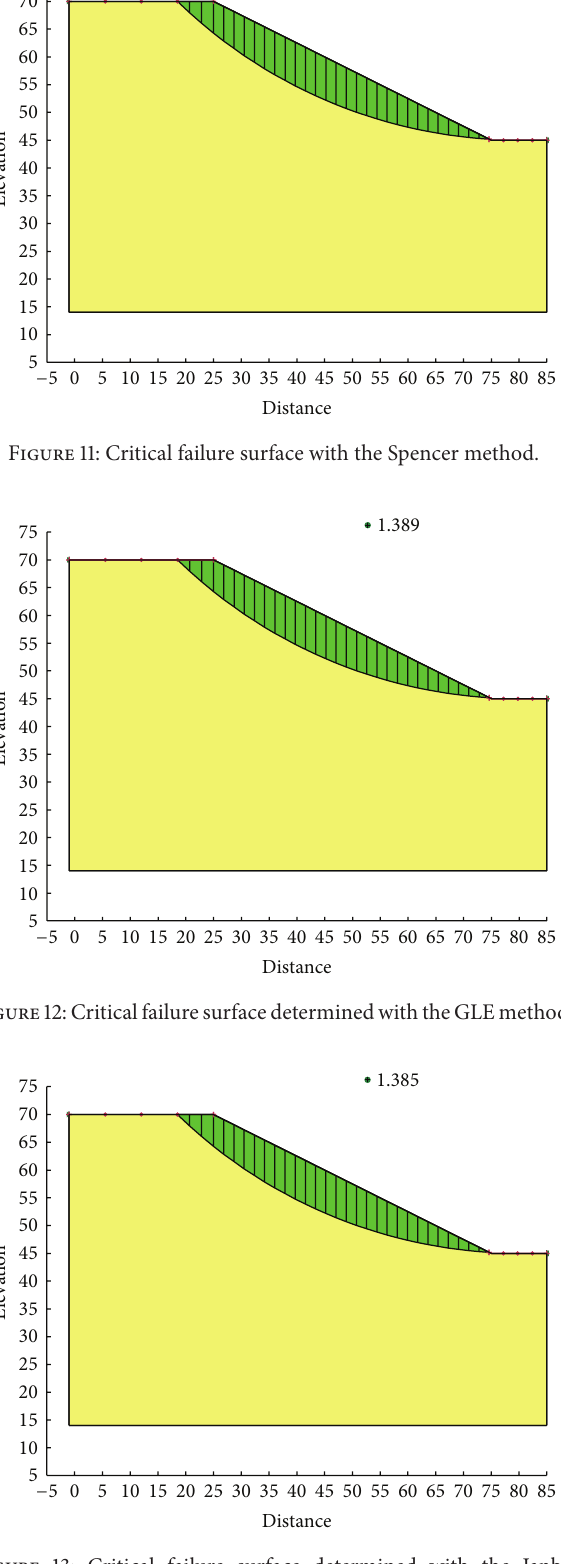
Figure 13: Critical failure surface determined with the Janbu generalized